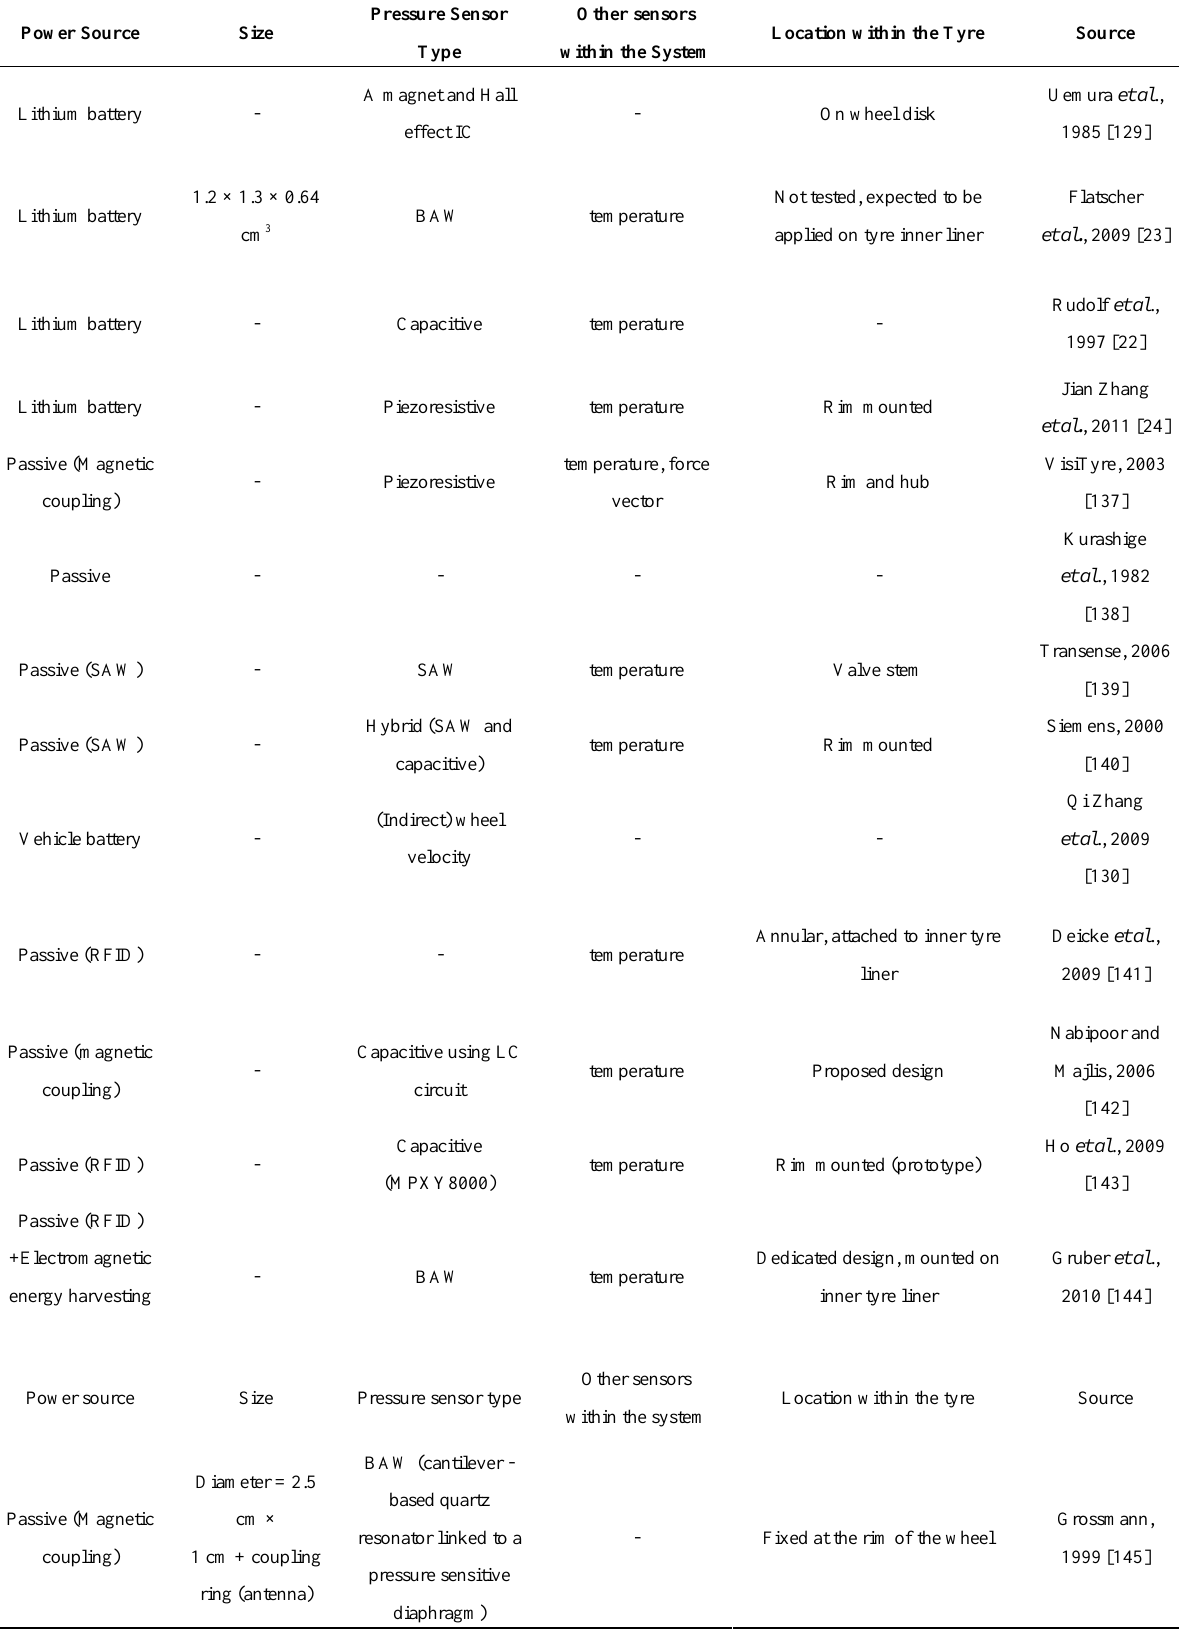
Table 3. Summary of published research for various types of battery powered TPMS for passenger